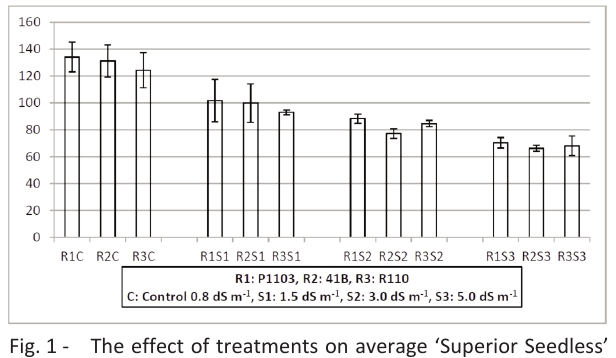
Fig. 1 - The effect of treatments on average ‘Superior Seedless’ leaf area (cm 2 ) grafted on the three rootstocks mea- sured on november, 2014.